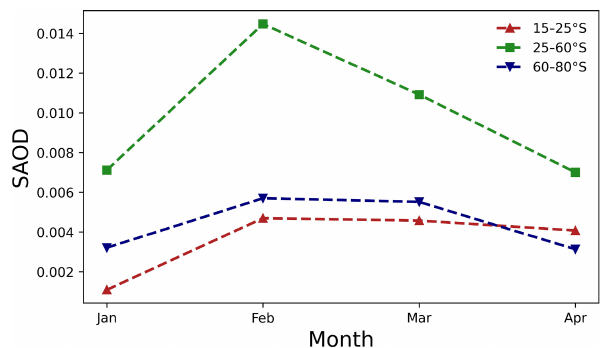
Figure 3. Monthly mean OMPS-LP stratospheric aerosol optical depth (SAOD), from January to April 2020, in the latitude interval 15–25 ◦ S (red upward triangles and line), 25–60 ◦ S (green squares and line) and 60–80 ◦ S (blue downward triangles and